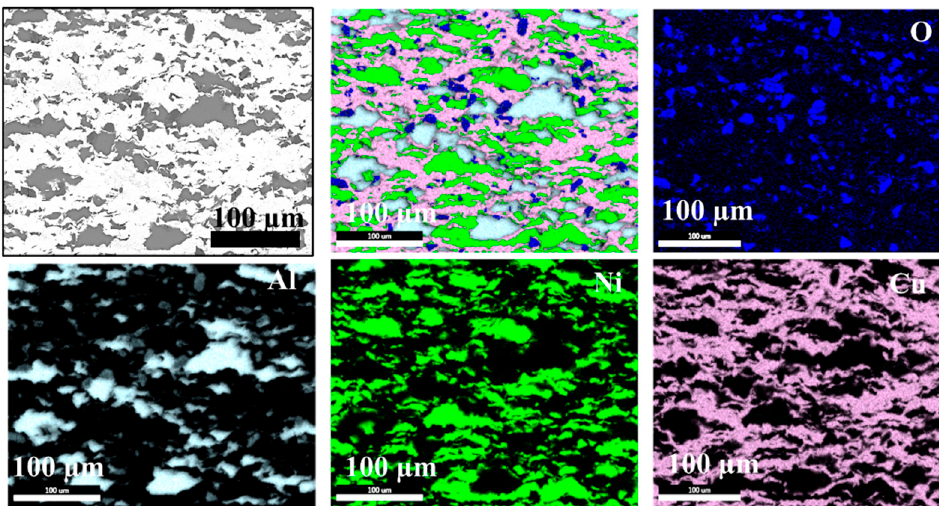
Figure 5. EDS mapping showing the elemental distribution of the S2 coating.